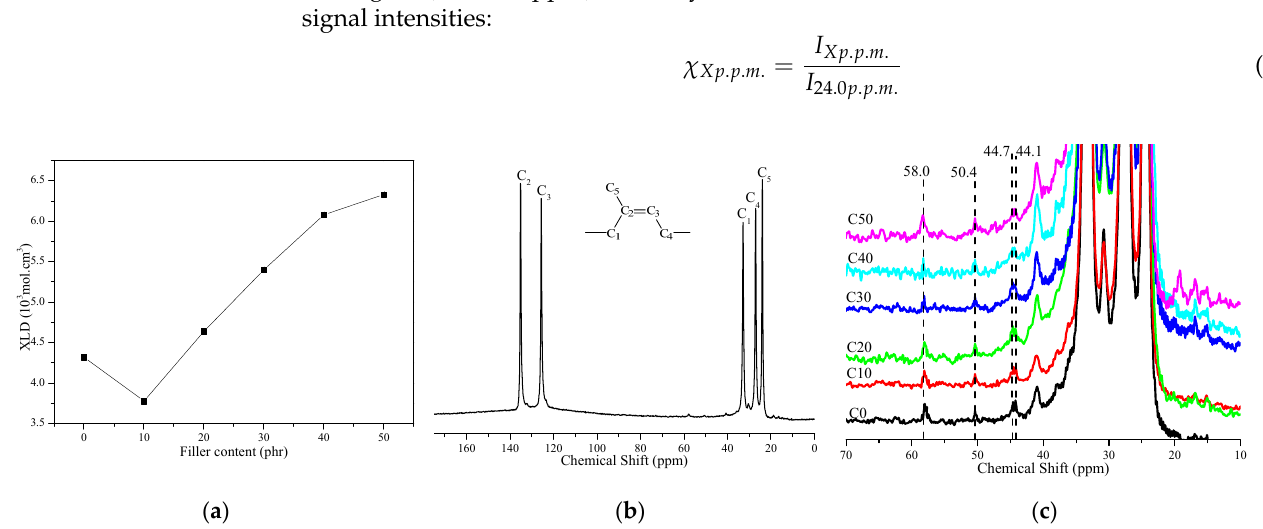
Figure 3. ( a ) Crosslink density (XLD), ( b ) full region of 13 C-NMR spectra and ( c ) region from 70–10 ppm of 13 C-NMR spectra of CSDPF/NR vulcanizates.